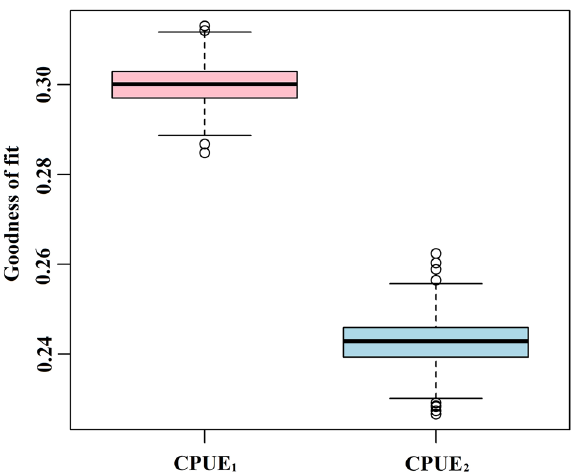
Figure 5. Model performance (goodness of fit, R 2 ) of 1000 runs of the gradient forest analysis for CPUE 1 and CPUE 2 .